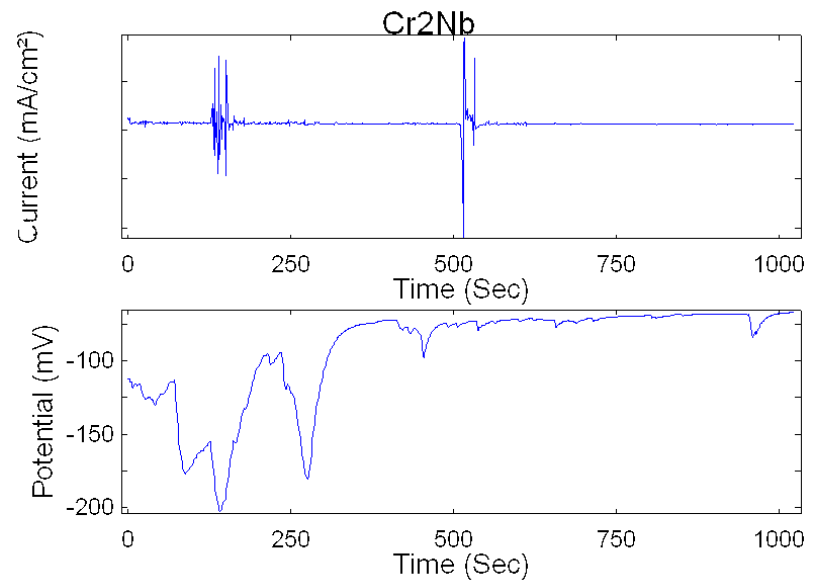
Figure 8. EN behavior at 0 h of milling.